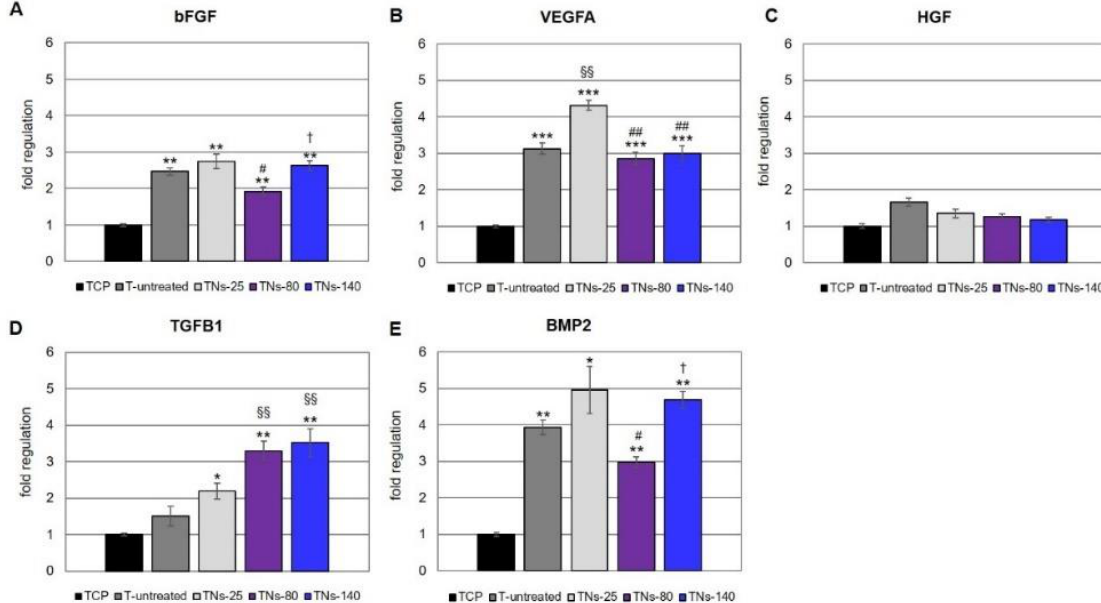
Figure 5. Gene expression profile of angiogenic-related markers in hMSCs seeded onto TNs for 7 days. Expression of ( A ) bFGF, ( B ) VEGFA, ( C ) HGF, ( D ) TGFB1, and ( E ) BMP2 measured by real- time PCR. Data are expressed as means ± SD of the target gene versus reference gene (TFRC) ratio and represented by 2 ΔΔCt . Note: * p < 0.05, ** p < 0.01, and *** p < 0.001 mark significant changes in gene expression level compared to hMSCs seeded onto TCP for the same culture time; §§ p < 0.01 indicates significant changes in gene expression versus hMSCs seeded on T-untreated; # p < 0.05 and ## p < 0.01 indicate significant changes in gene expression versus hMSCs seeded on TNs-25; † p < 0.05 indicate significant changes in gene expression versus hMSCs seeded on TNs-80.